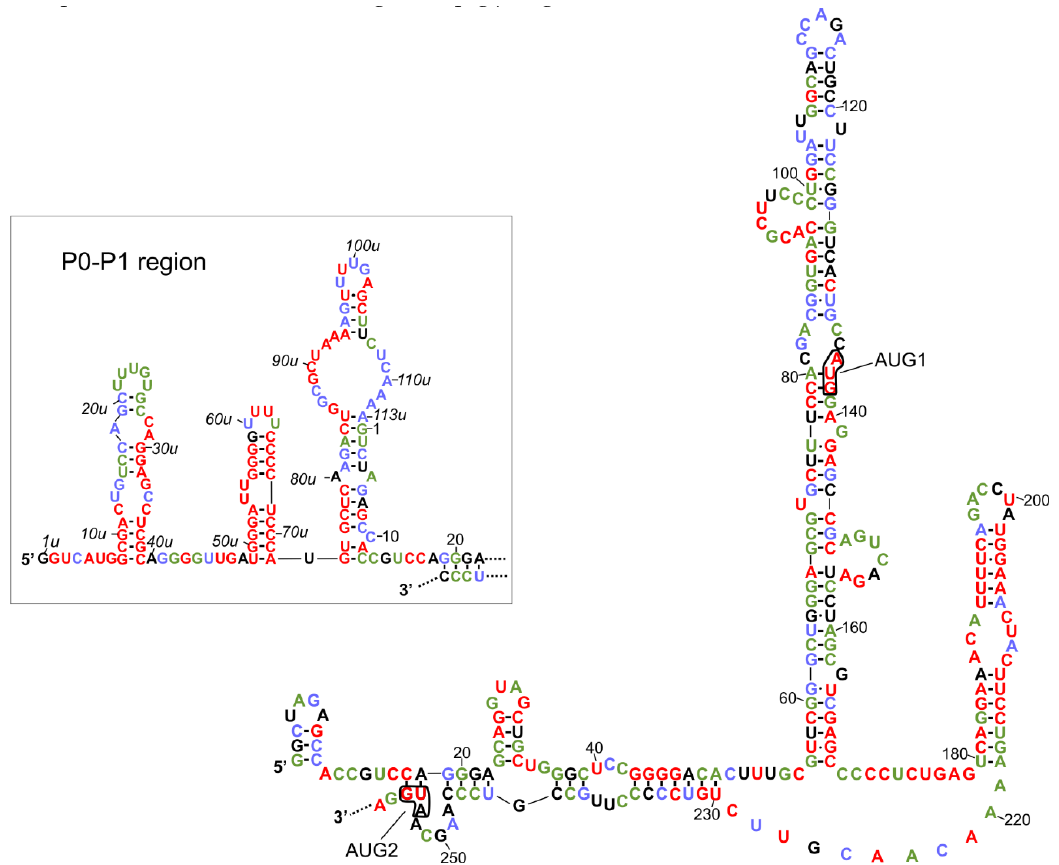
Figure 1. Se condary structure models of the 5′ terminal regions of p53 mRNA that begin at P1 and P0 (in the box) transcription initiation sites. The level of each nucleotide conservation is marked based on the alignment of p53 mRNA sequences derived from eleven different species (Figure 2 in the citation [36]). The nucleotides are colored according to the percentage of their conservation (red, 100%; green, 80 – 99%; blue, 60 – 79%).